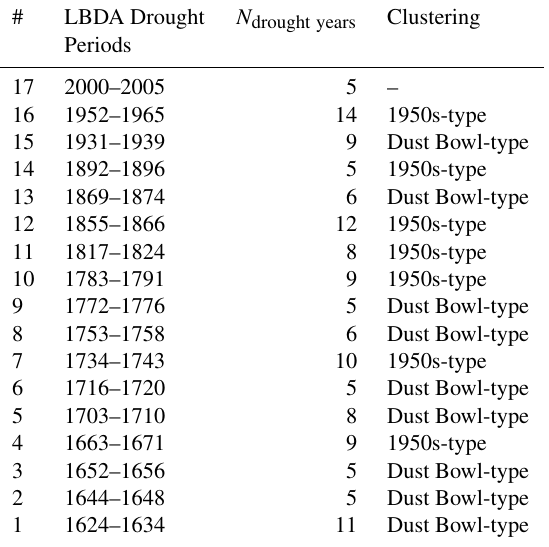
Table 1. Drought periods since 1600 based on clustering with LB- DAv1, drought duration, and attribution to